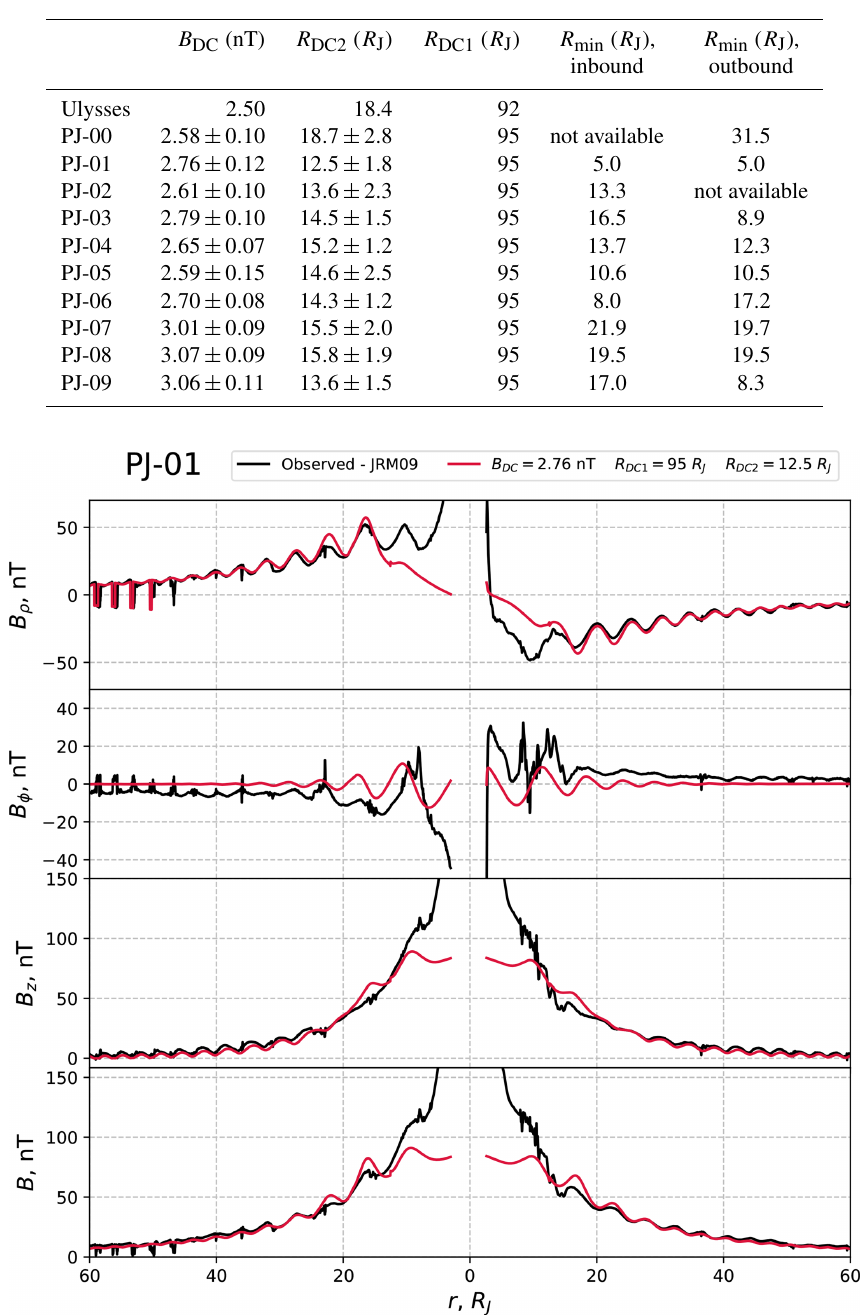
Figure 5. Observed (black) and modelled (red) residual fields in JSM cylindrical components, together with the residual field magnitude, for Juno perijove 1. The residual field is the observed field with the JRM09 internal field subtracted. The fields are plotted versus spherical radial distance with inbound data shown on the left and outbound data on the right. The same model field is used for both.